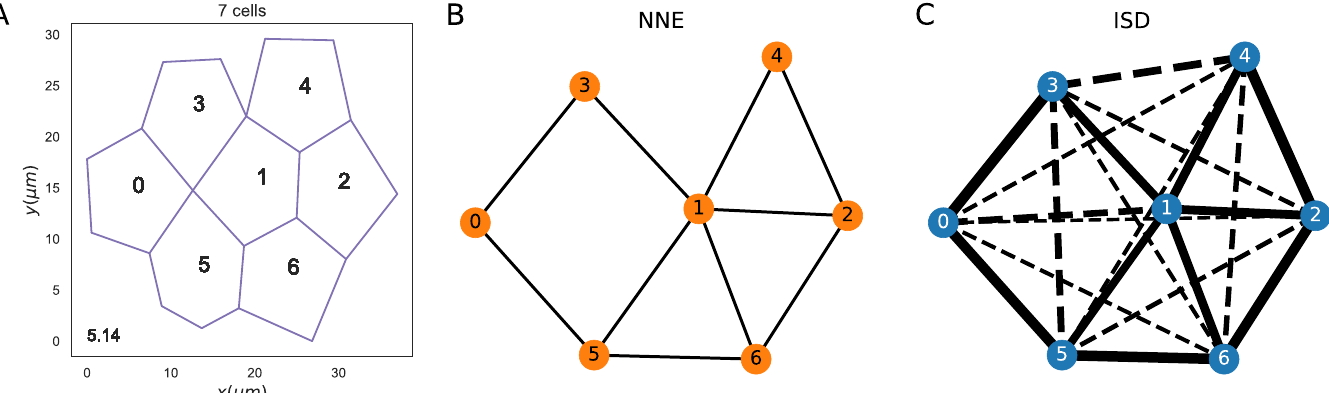
Fig 3. The exchange rates in two different cell communication models. A: Configuration of 7 cells with a mean polygon number equal to 5.14. B,C: The exchange rates between the cells of panel A are shown in weighted graphs where nodes are cells and edge thickness represents the magnitude of the exchange rate. Panel B refers to the NNE communication, where only nearest neighbours can exchange the global reporter. Panel C illustrates the exchange rates in the ISD model, where also non-nearest neighbours (joined by dashed edges) can communicate via the global reporter. Parameter values: γ = 0.1 s − 1 for the NNE model; D = 1000.0 μm 2 / s and α = 1.0 s − 1 for the ISD